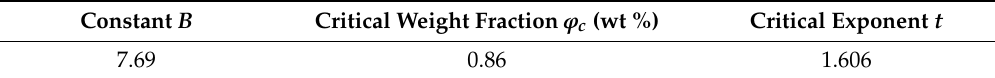
Figure 5. Electrical resistivity of CNF/GFRP laminates as a function of CNF content (inset: logarithm of conductivity as a function of the logarithm of the reduced weight fraction and fit to a line). Table 1. The results calculated with classical percolation theory.